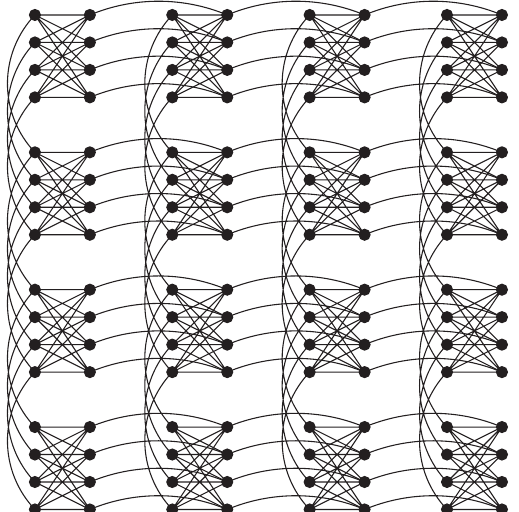
ffiffiffiffiffiffiffiffi ffiffiffiffi p p 128 N . The high con- ¼